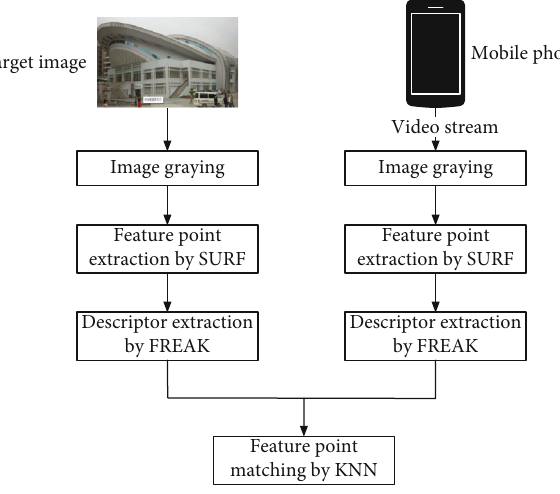
Figure 1: The fl ow chart of the SUFREAK algorithm.